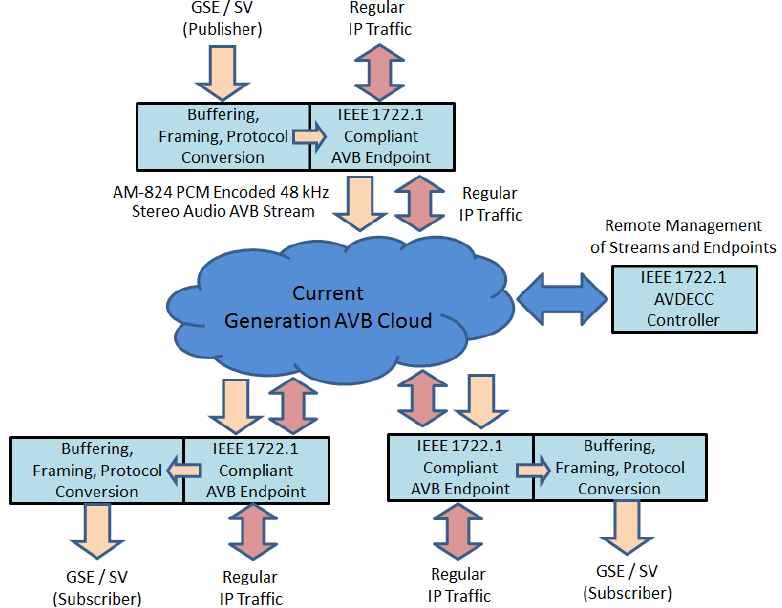
Figure 5. Implementation of proposed reconfigurable architecture using current-generation AVB technology and bump-in-the-wire (Bit-W) devices at the S-Node interfaces.